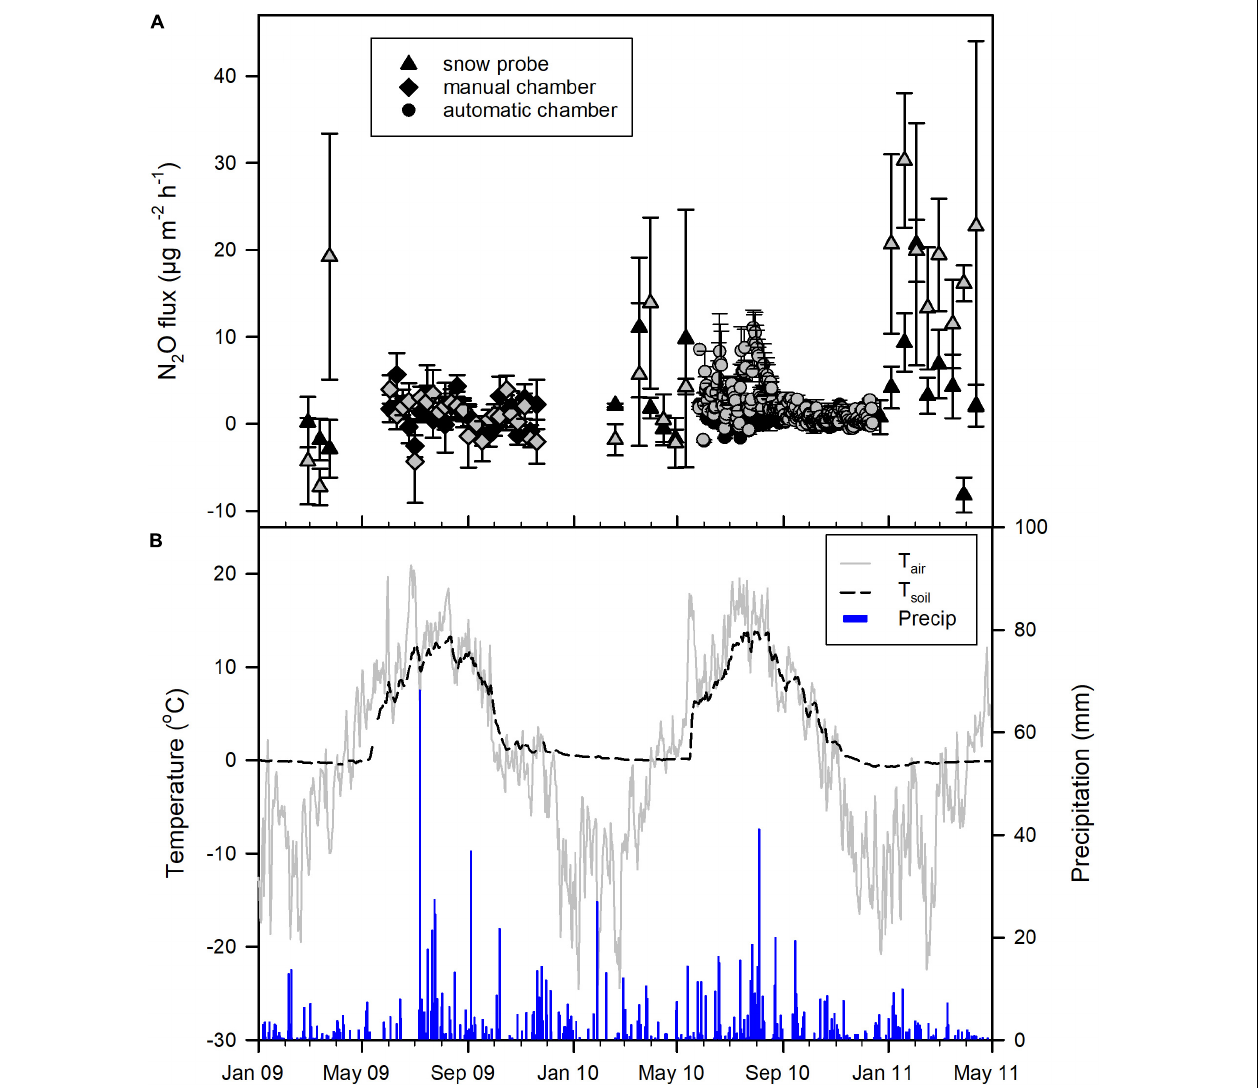
FIGURE 1 | (A) Soil emissions of N 2 O from a Norway spruce forest at Flakaliden from non-fertilized control (black symbols) and fertilized plots (gray symbols). Data are means and standard deviation. (B) Air and soil (20 cm depth) temperature as well as precipitation at